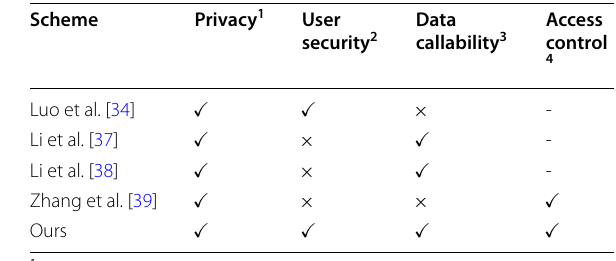
1 The privacy protection for user data held by data providers. 2 The security of user personal information.